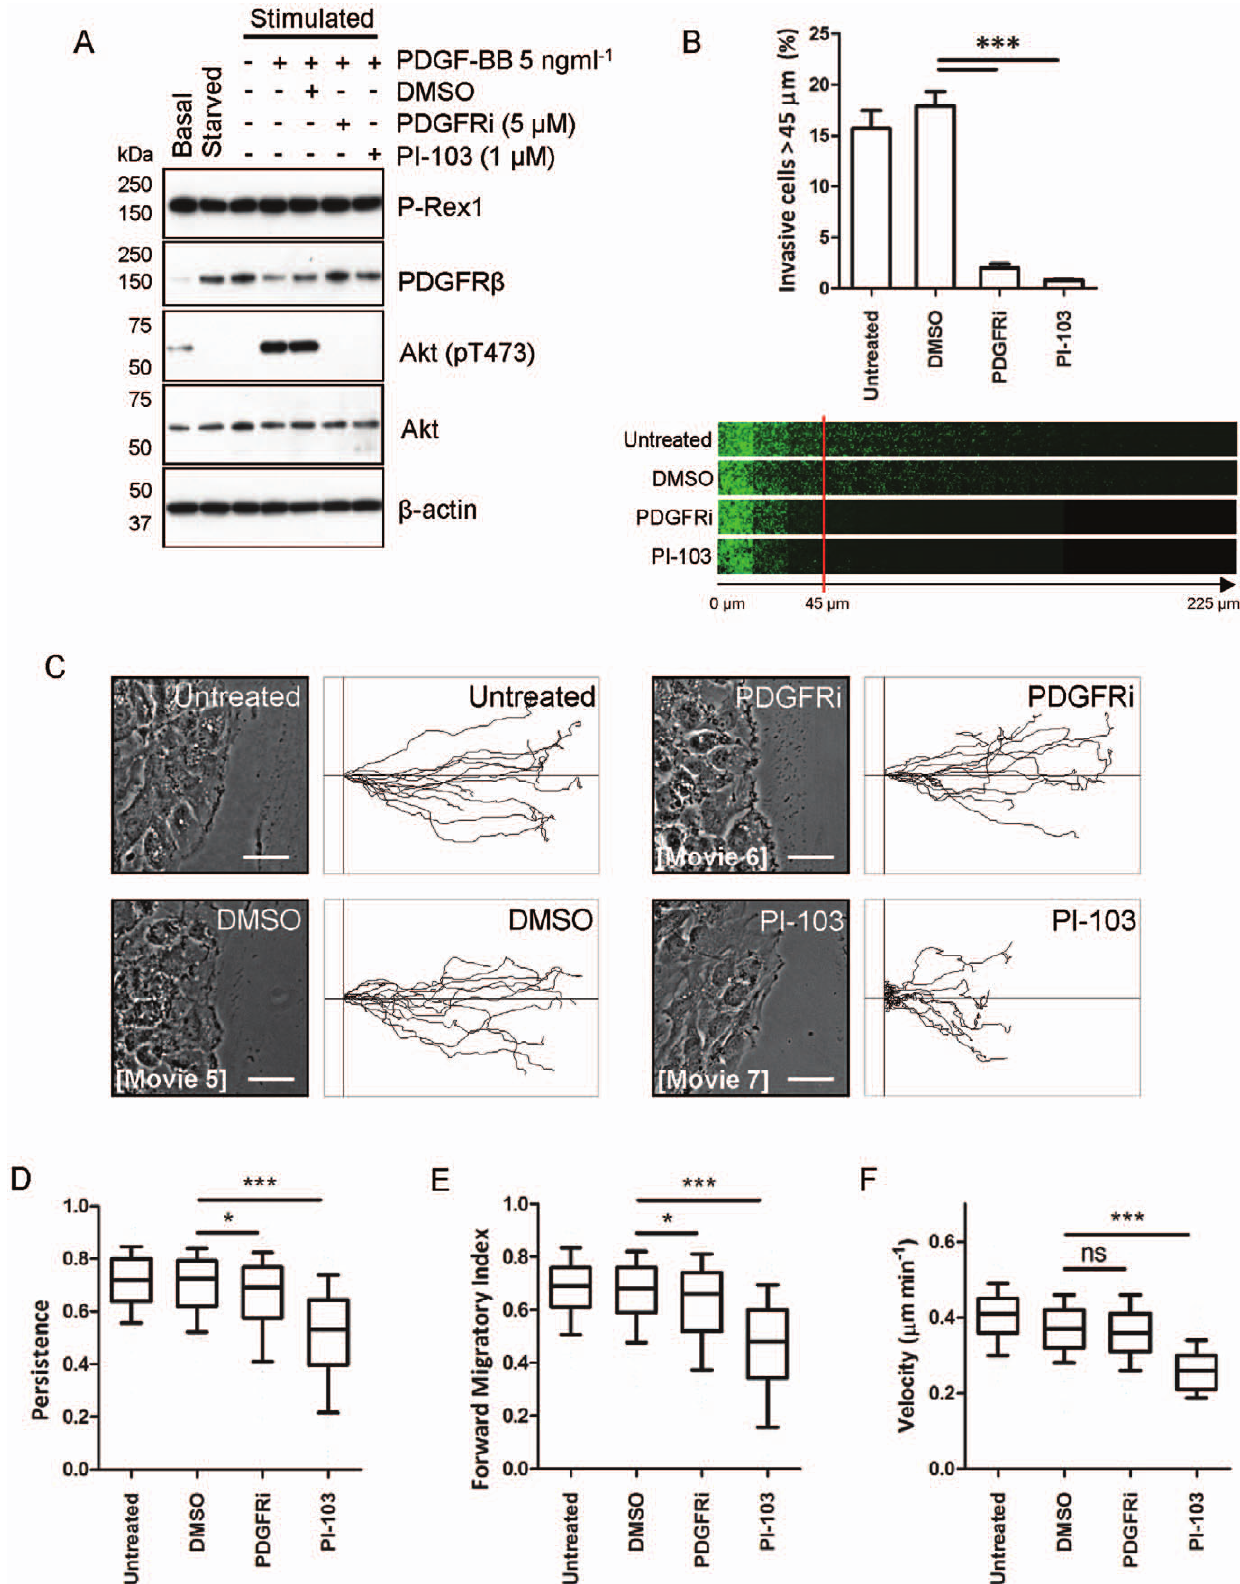
Figure 8. Chemical inhibition of PDGFR signalling alters the migratory behaviour of P-Rex1 expressing cells in both 2D and 3D environments. (A) Following a period of serum starvation, P-Rex1 expressing fibroblasts were stimulated with PDGF-BB, in the presence and absence of DMSO control or chemical inhibitors as indicated. Cells were the lysed and the levels of P-Rex1 and PDGFR b were determined by Western